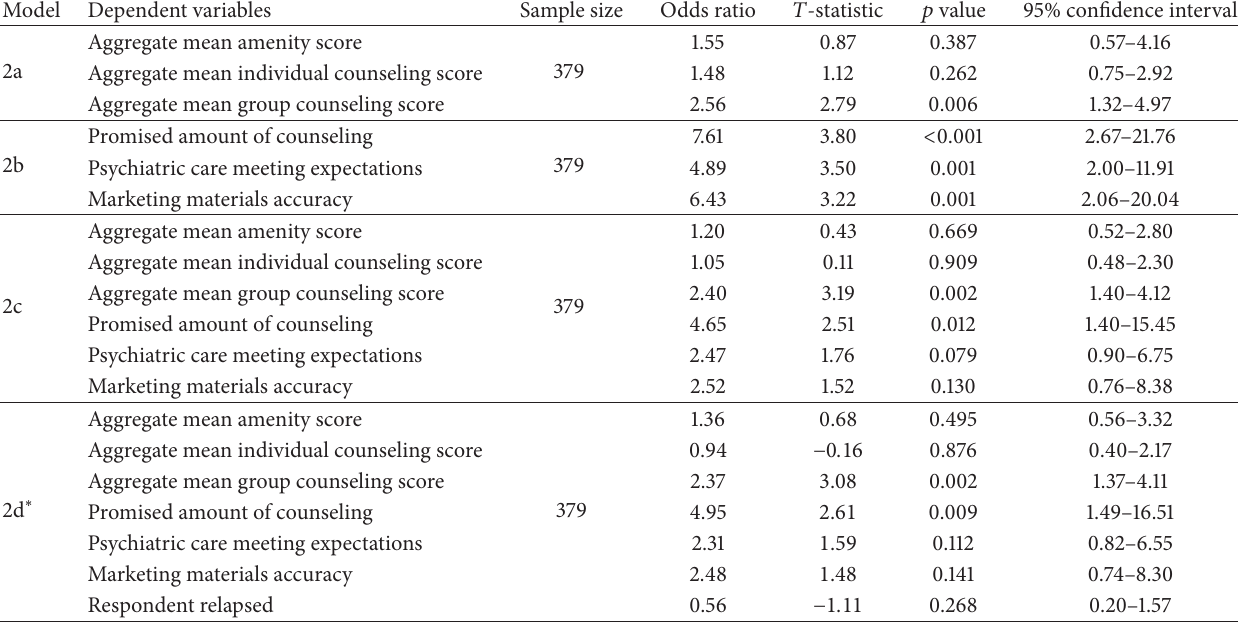
Table 4: Regression outcomes